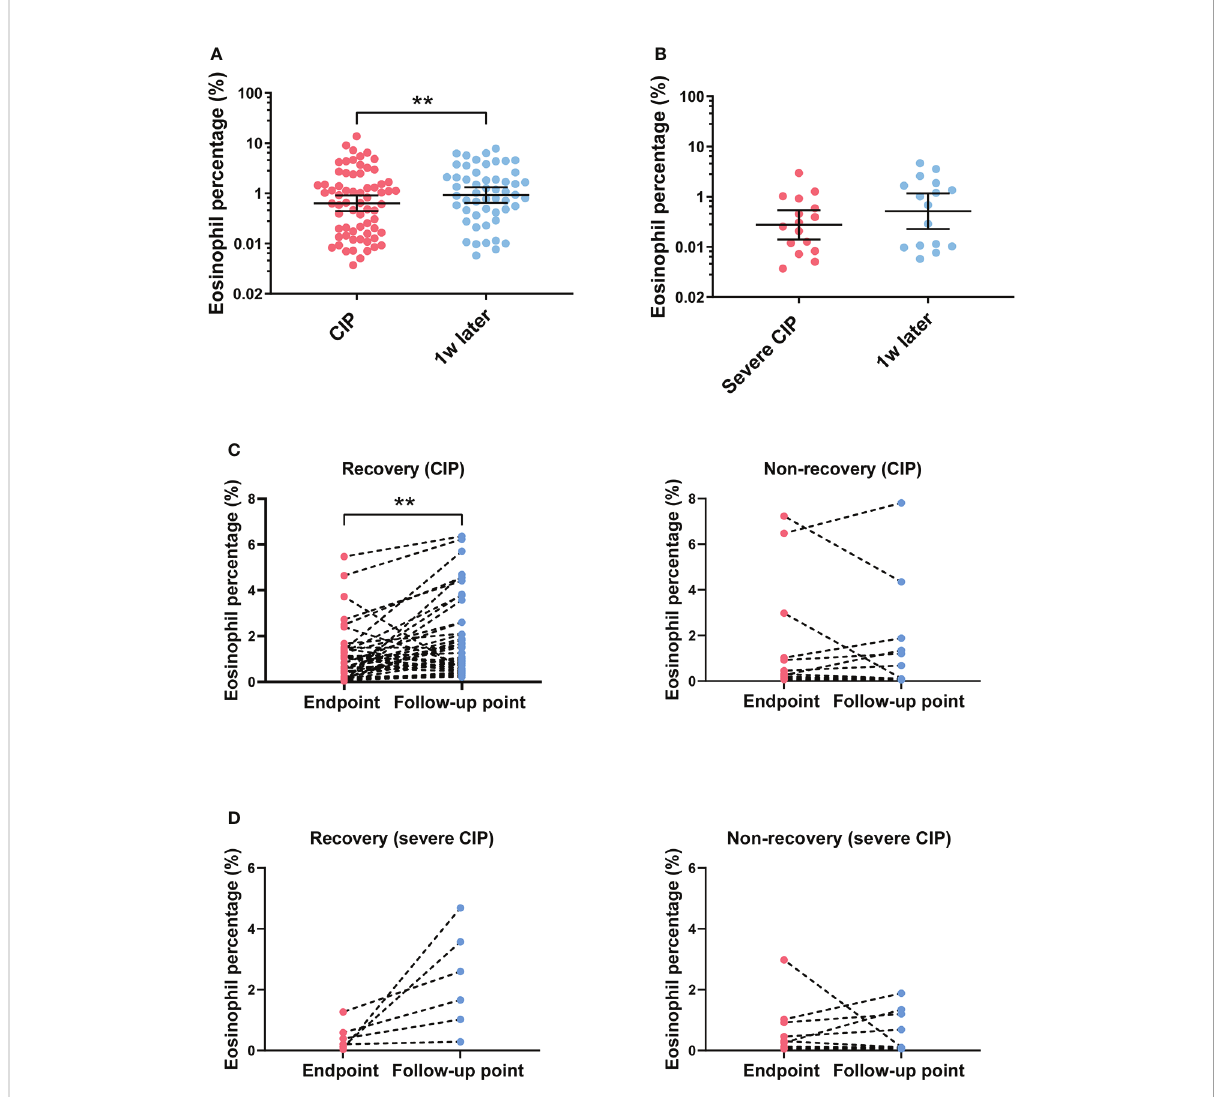
FIGURE 4 Eosinophil percentage trend and its correlation with outcomes after the endpoint. (A) Eosinophil percentage at different times after endpoint in patients with CIP. Bars indicate the geometric mean and 95%CI. One-way ANOVA with mixed-effects model followed by Holm – Sidak ’ s post- hoc test. ** p < 0.01. (B) Eosinophil percentage at different times after endpoint in patients with severe CIP. Bars indicate the geometric mean and 95%CI. One-way ANOVA with mixed-effects model followed by Holm – Sidak ’ s post-hoc test. (C) Eosinophil percentage trend from endpoint to the follow-up point in the recovery group and the non-recovery group (patients with CIP). Paired t -test. ** p < 0.01. (D) Eosinophil percentage trend from the endpoint to the follow-up point in the recovery group and the non-recovery group (patients with severe CIP). Paired t -test. CIP, checkpoint inhibitor pneumonitis; CI, con fi dence